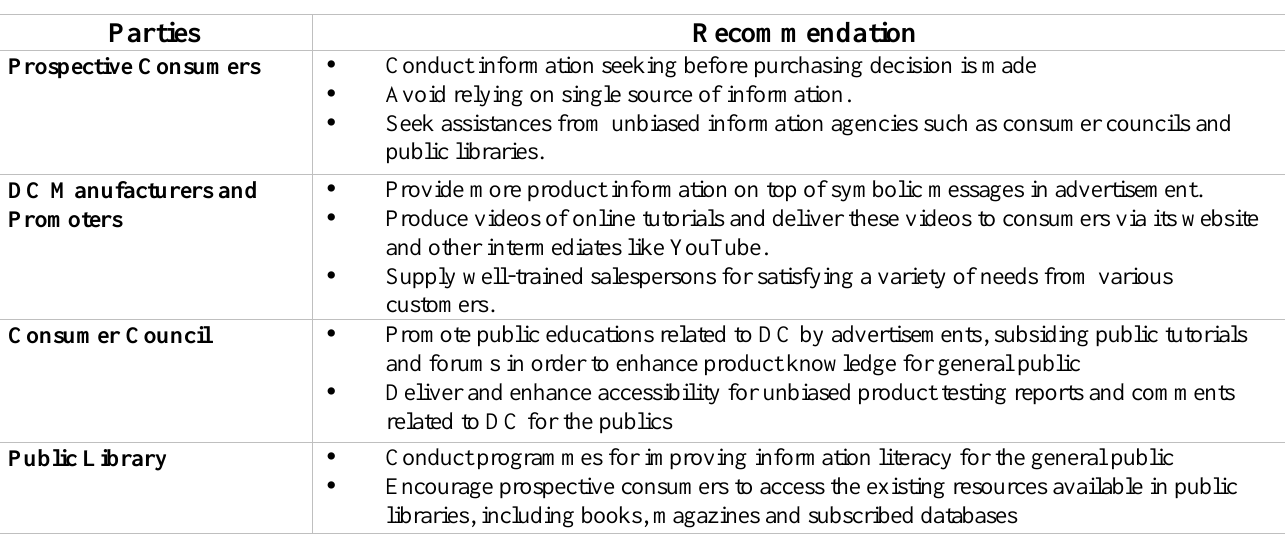
Table 15. Recommendations to various